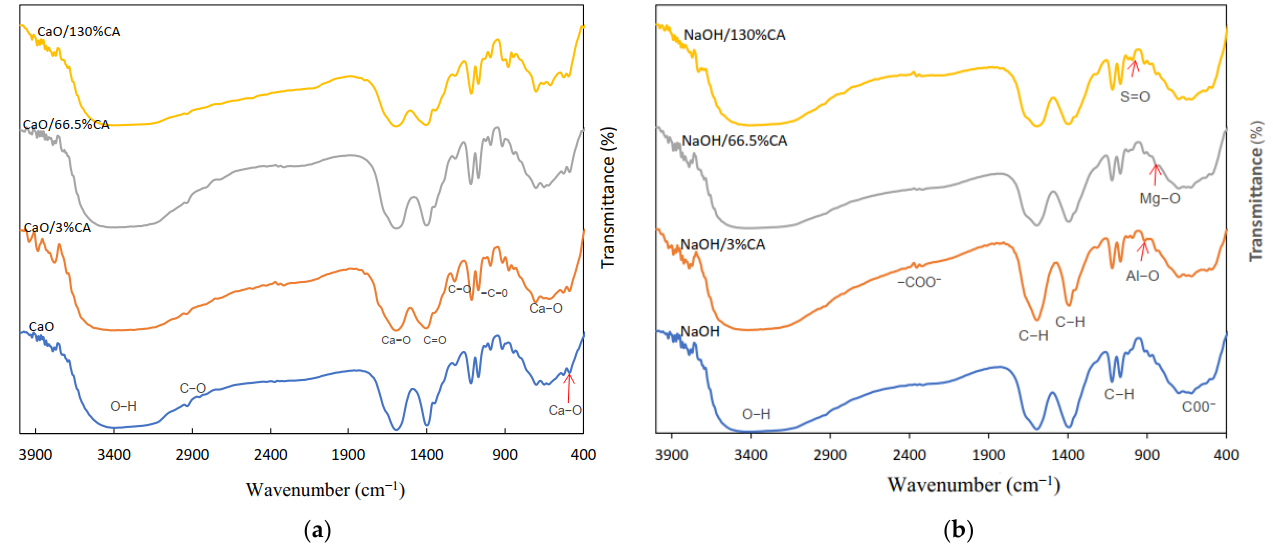
Figure 2. FTIR spectra of different CA loading wt.% on base catalyst: ( a ) CaO/CA; ( b ) NaOH/CA. Stretching vibrations corresponding to -C-O appear in the region between 1100 cm −1 and 900 cm −1 indicating that CA was chemically bonded to the surface of CaO [56]. All spectra show strong absorption at 723 cm −1 and 454 cm −1 which is attributed to the Ca-O bond and the bending mode of CaCO 3 vibrations [61]. The peaks intensity of CaO and those of the synthesized catalysts did not change, suggesting that the synthesis connected the CaO surface chemically without modifying the functional group of CaO.